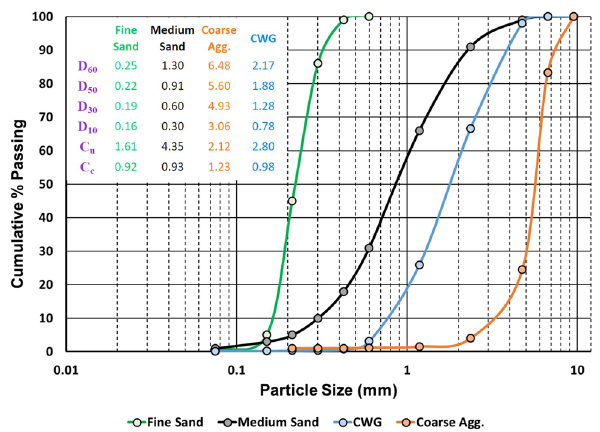
Fig. 2 Gradation curves of the materials used in this study. The uniformity coefficient (C the measures of sand/CWG gradation defined as D (D D ), respectively. Also, D 60 10 with diameters smaller than x%